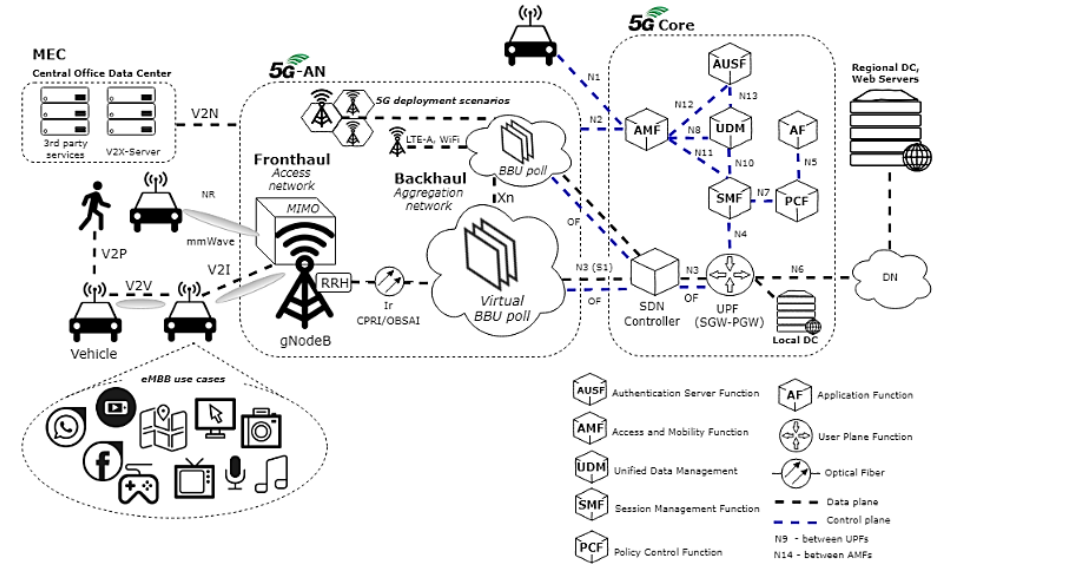
Figure 3. 5G V2X